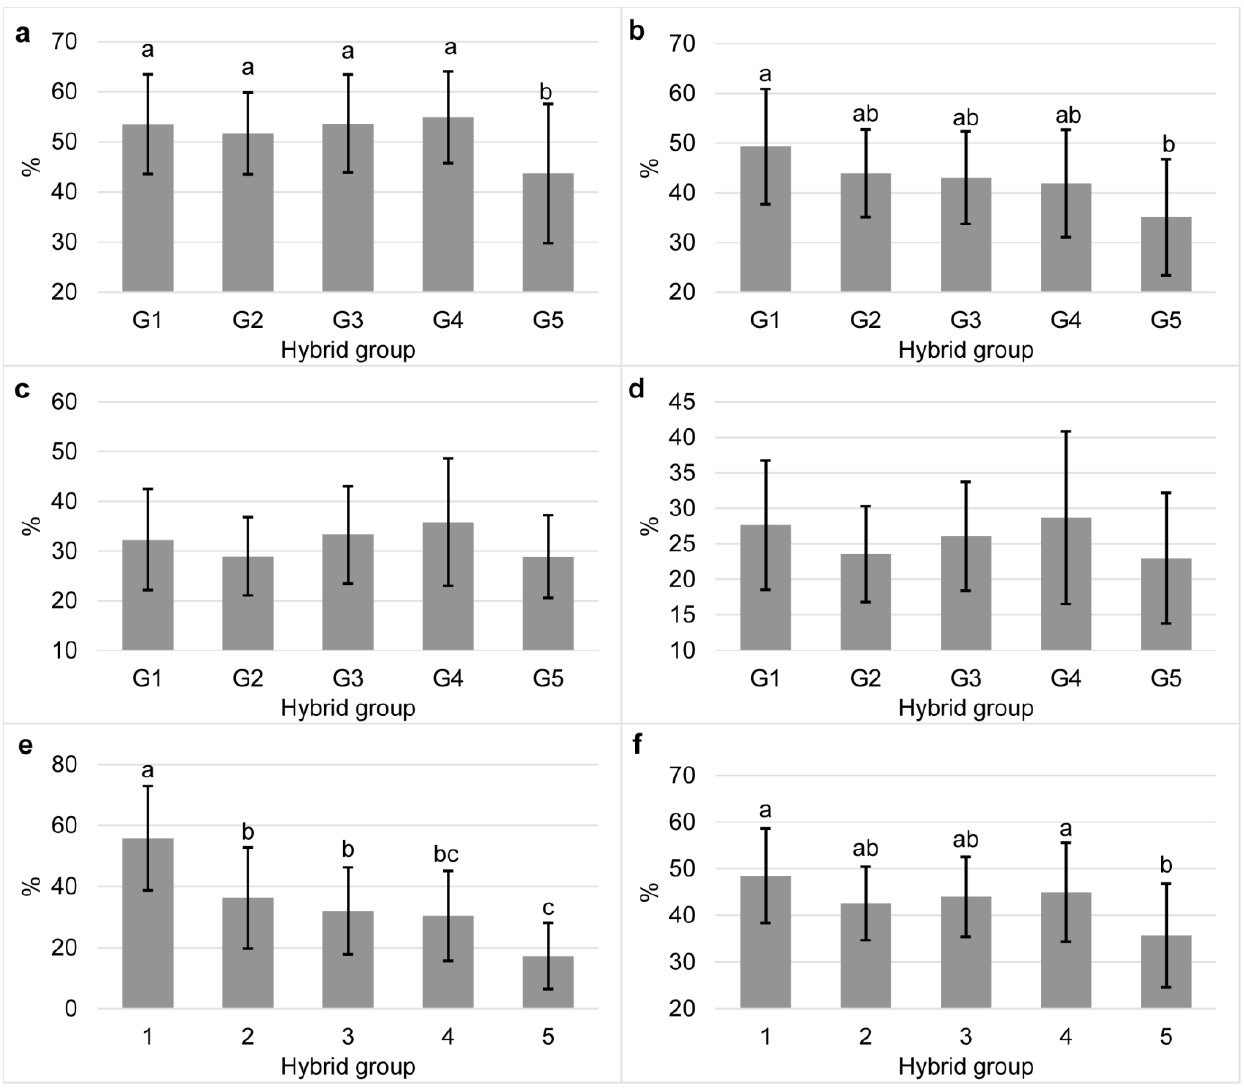
Figure 3. Bioaccessibility of individual ( a) , lutein; ( b ), zeaxanthin; ( c ), α -cryptoxanthin; ( d ), β -cryptoxanthin; ( e ), β -carotene) and total carotenoids ( f ) of commercial maize hybrids classified into five groups according to the total carotenoid content (G1, <15; G2, 15–20; G3, 25–25; G4, 25–30, and G5, >30 µg/g DM). Different small letters represent statistically significant differences ( p < 0.05) between hybrid groups. Error bars represent SD.